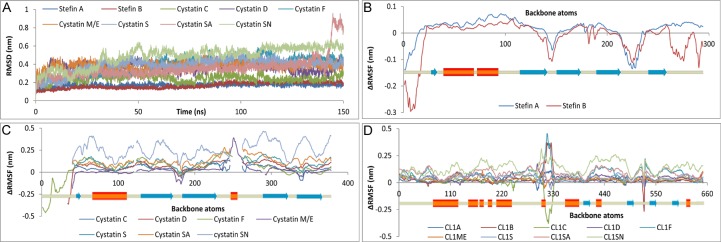
Stability of the complexes.RMSD of cathepsin L1-stefin/cystatin complexes (A) and ΔRMSF (RMSFbound—RMSFunbound) in stefins (B), cystatins (C) and cathepsin L1s (D).